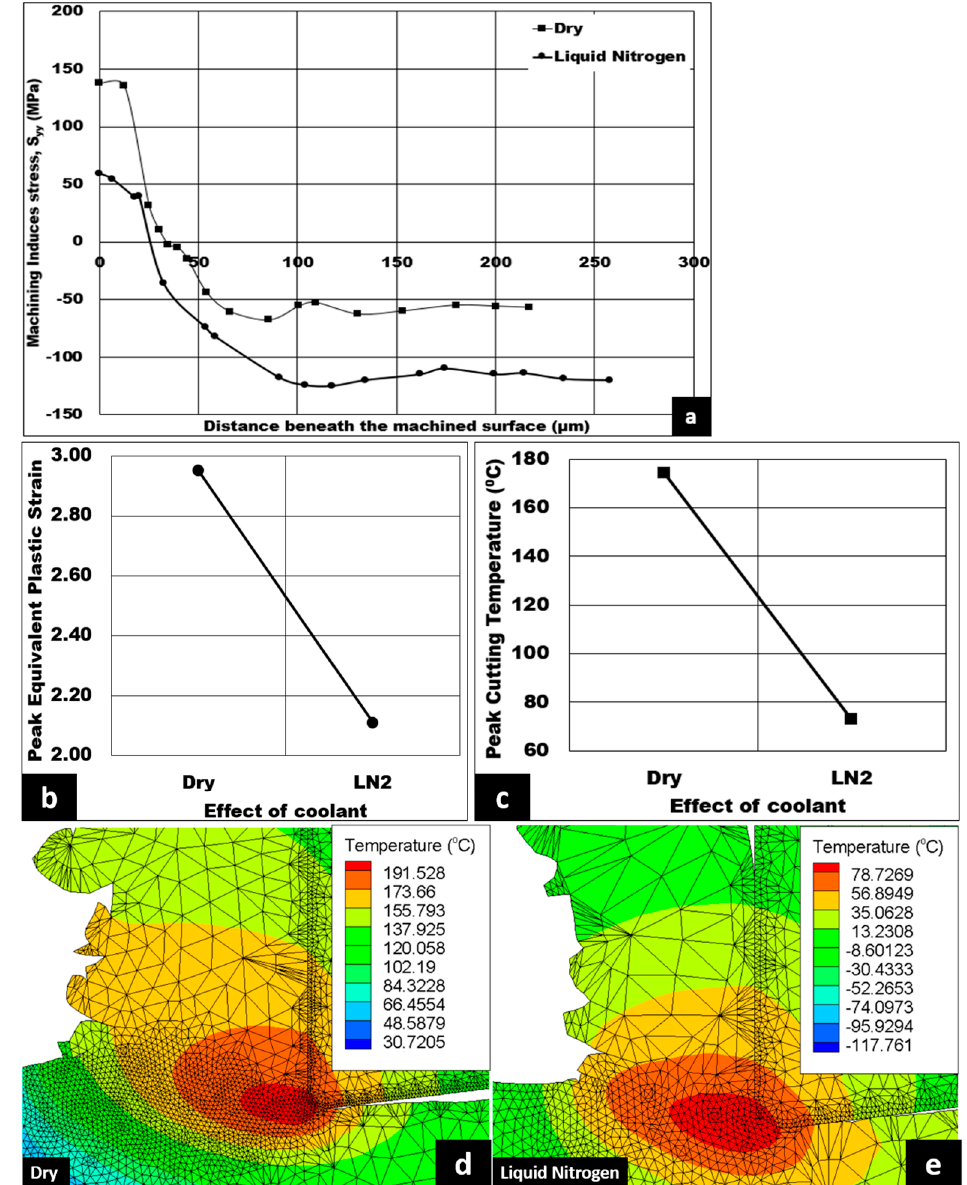
Figure 12. ( a ) Numerical machining induced stress distribution, and variation of ( b ) peak equivalent plastic strain and ( c ) peak cutting temperature under the influence of coolant (10% volume fraction, cutting speed = 50 m/min, uncut chip thickness = 0.07 mm, average size = 0.3 mm, volume fraction 10%); Corresponding temperature contours at ( d ) dry and ( e ) liquid nitrogen conditions respec- tively.